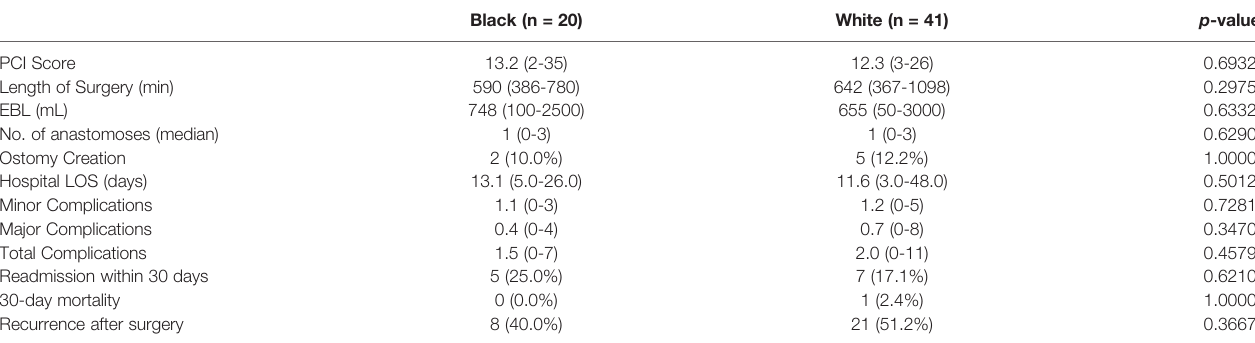
TABLE 2 | Patient intraoperative and postoperative outcomes within 30 days of surgery by race.